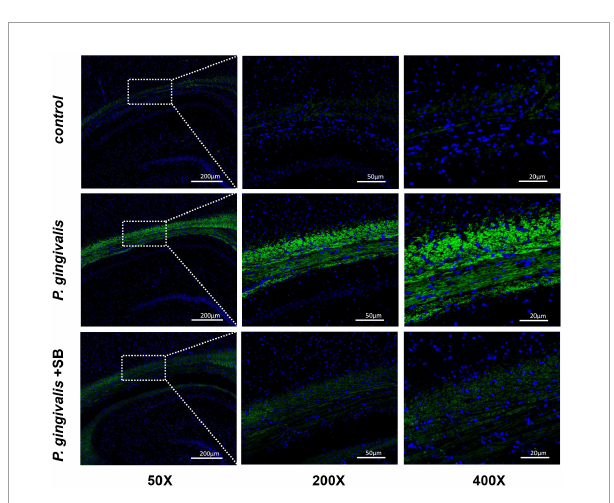
FIGURE8 Expression of P. gingivalis in the hippocampal tissue as assessed by FISH. Blue represents the nucleus, and green is the region where P. gingivalis is present ( n = 3 per group) (50 × , 200 × , and 400 × , bar = 200 µ m, bar = 50 µ m, and bar = 20 µ